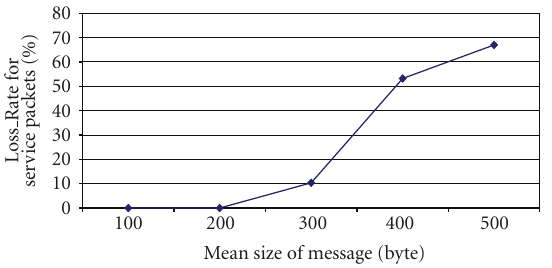
Figure 14: Service Packets-Loss Rate versus Mean Message Size (message generation rate = 150 msgs/s and mean number of neighbors = 50).